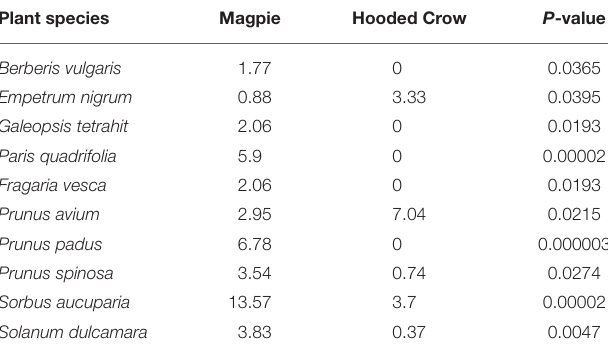
TABLE 2 | Plant species with a significant difference in the frequency of occurrence (given as %) of intact seeds between the pellets of Magpies and Hooded